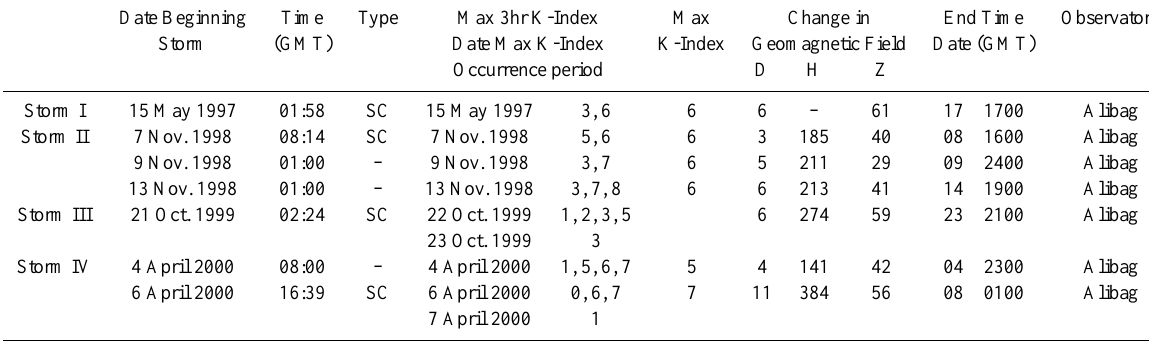
Table 1. Details of the magnetic storm events examined in the present